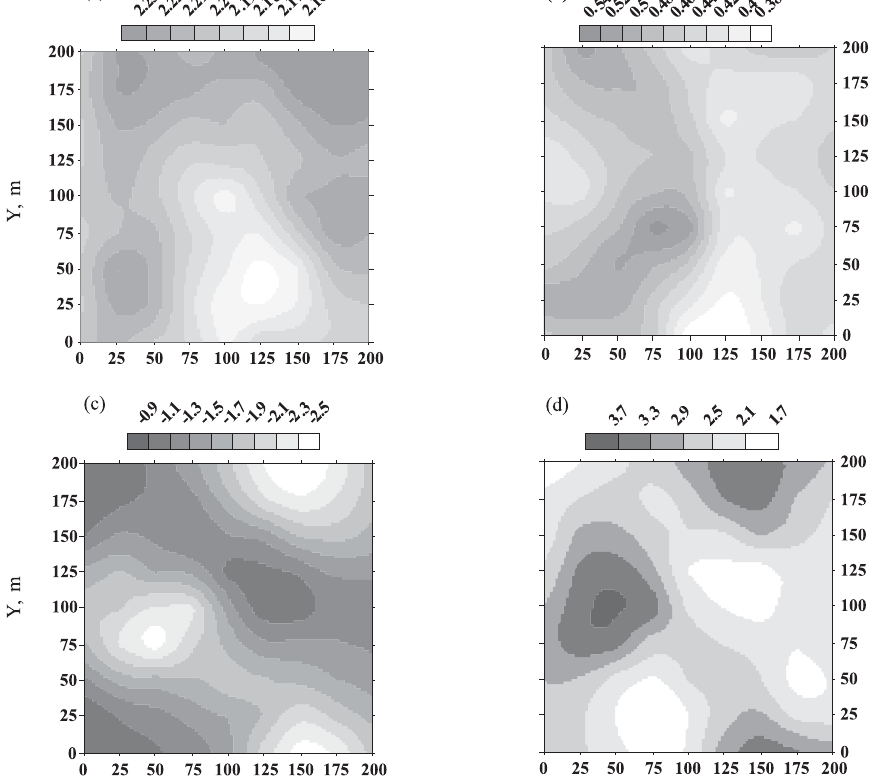
Figura 6. Mapas de isolinhas do Latossolo Amarelo: (a) n , (b) θθ θθ θ